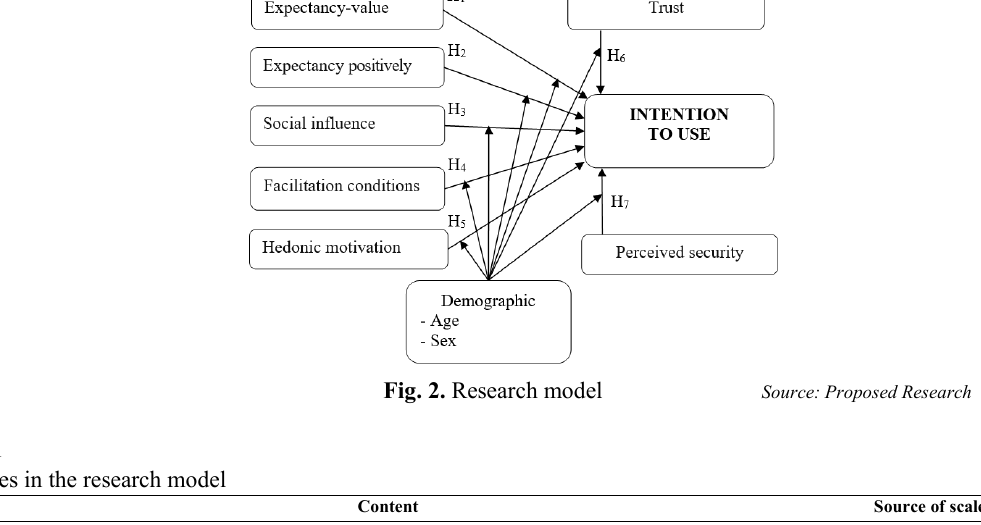
H 7 : Perceived security positively influences the intention to use mobile apps for room-sharing. Based on the developed hypotheses, the research model is formed, as shown in Figure 2. The variables in the research model are shown in Table 1.